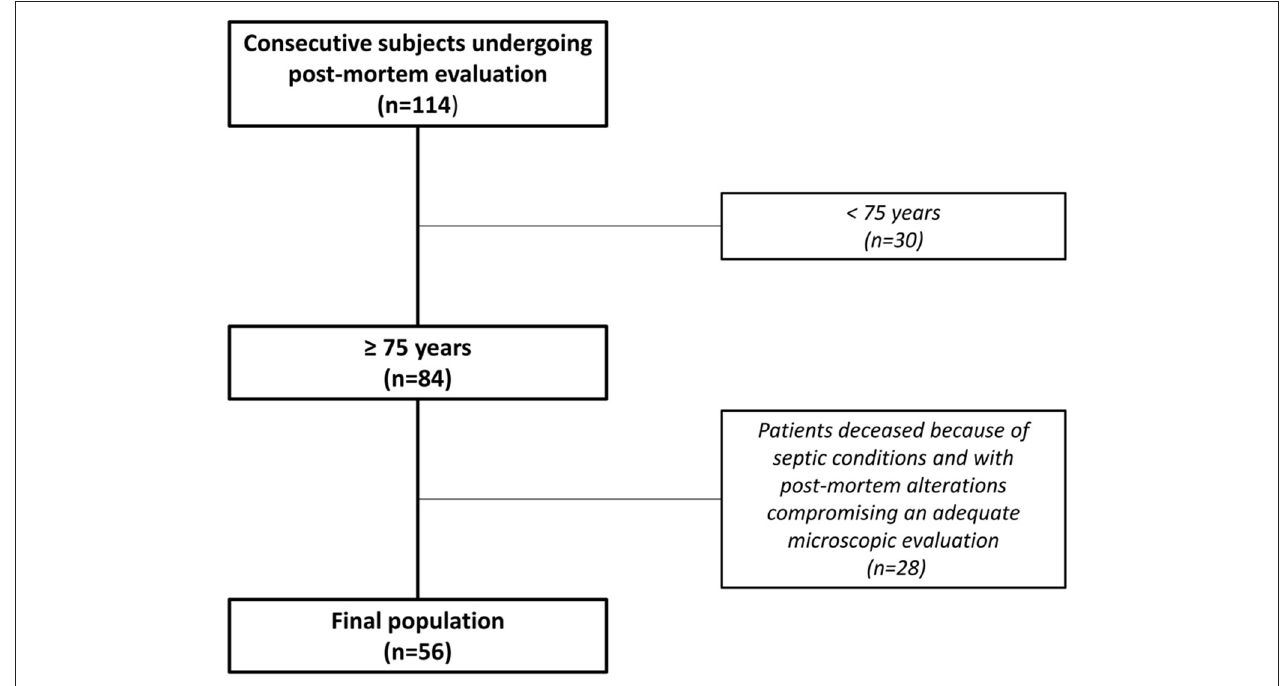
FIGURE 2 | Study design. Flow-chart showing selection of the final